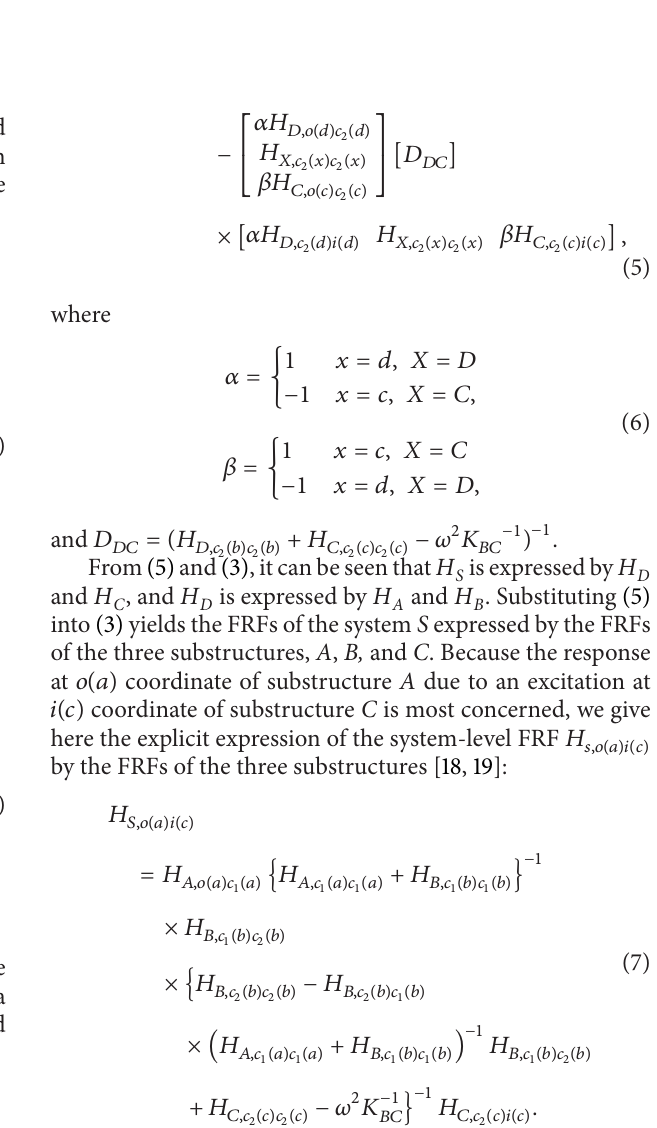
Figure 3: Multicoordinate coupled three-substructure